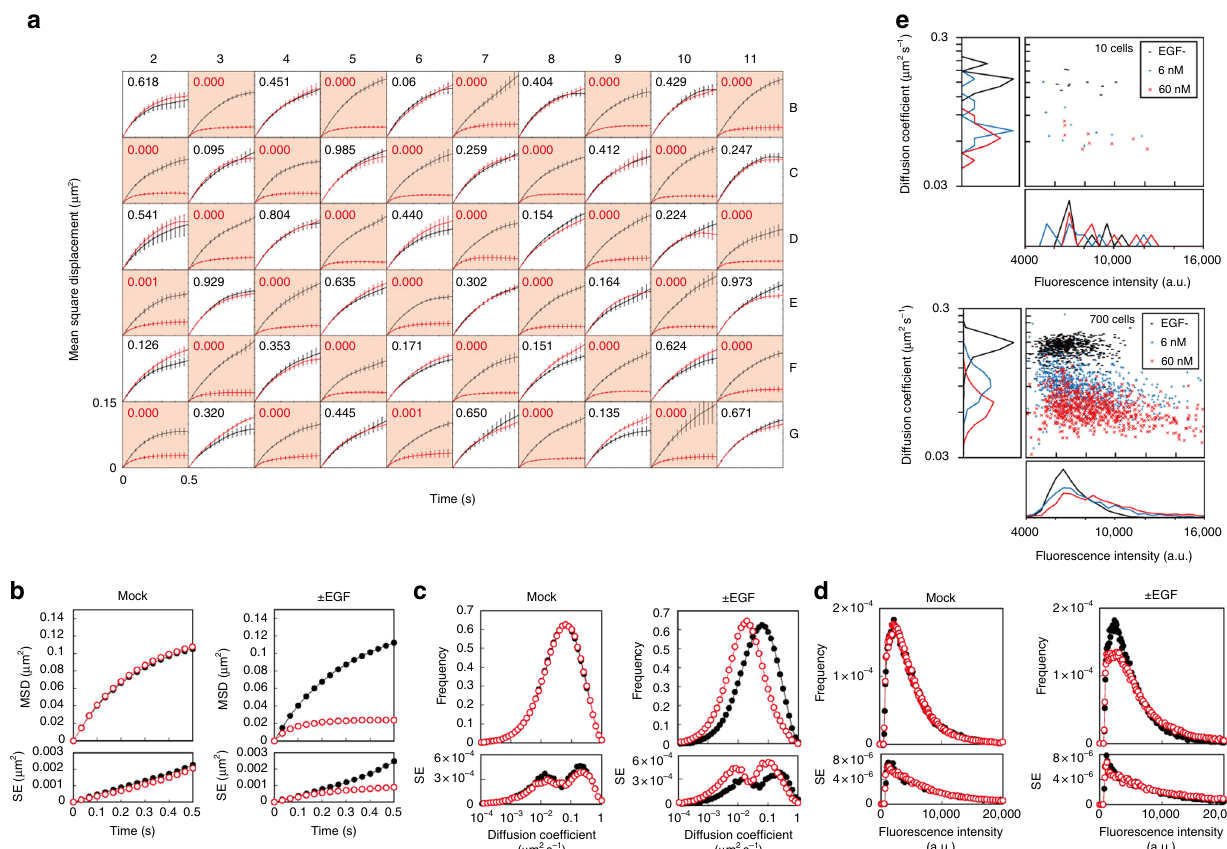
Fig. 2 Single-molecule analysis in living cells using the automated system. a Time evolution of the MSD of EGFR-GFP spots analyzed using the data shown in Fig. 1b. EGF (60 nM) or mock solution was added to each well (red or white background, respectively). P -values of the distribution of the MSD at Δ t = 66 ms before and after addition of the solutions are indicated, and signi fi cant differences (<0.005) are shown in red. The number of observed cells and molecules was 591 and 236,035, respectively. The MSD was calculated for every cell. Curves and error bars indicate the average and SE between cells. b – d Changes in the behavioral properties of EGFR molecules induced by EGF. Upper and lower panels represent the mean and SE between cells, respectively. A recording of a cell was considered successful if the number of spots in a 1 s observation was greater than zero. Distributions of the MSD ( b ), diffusion constant at Δ t = 66 ms ( c ), and fl uorescence intensity in the fi rst frame ( d ) are shown before (black) and after (red) the addition of EGF (right) or mock (left) solution. e Distribution of diffusion coef fi cients and fl uorescence intensities in 10 (upper) and 700 (bottom) cells. The means and standard deviations at 0, 6, and 60 nM EGF were 0.16 ± 0.022, 0.092 ± 0.027, and 0.065 ± 0.017 µ m 2 s − 1 for the diffusion coef fi cients and 6766 ± 1229, 7790 ± 2576, and 8849 ± 3393 a.u. for the fl uorescence intensities, respectively. Panels on the left and bottom of each two-dimensional map show the histograms of the diffusion coef fi cients and fl uorescence intensities,